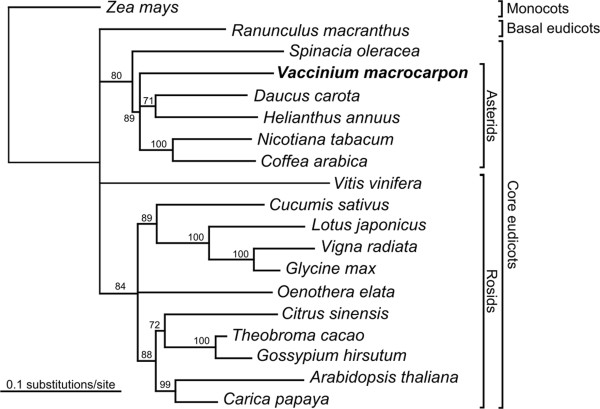
Multi-gene phylogenetic tree of cranberry and 18 other plant species. This maximum likelihood (RAxML) tree was built using two plastid (atpB, rbcL) and one mitochondrial (matR) gene sequences which were concatenated and aligned, using MUSCLE (EMBL-EBI), with those of 18 other plant species including Rosids, Asterids, monocots and a basal eudicot. The results of 100 bootstrap replicates are shown at the nodes of this unrooted phylogeny. Branch lengths are proportional to divergence (see scale).